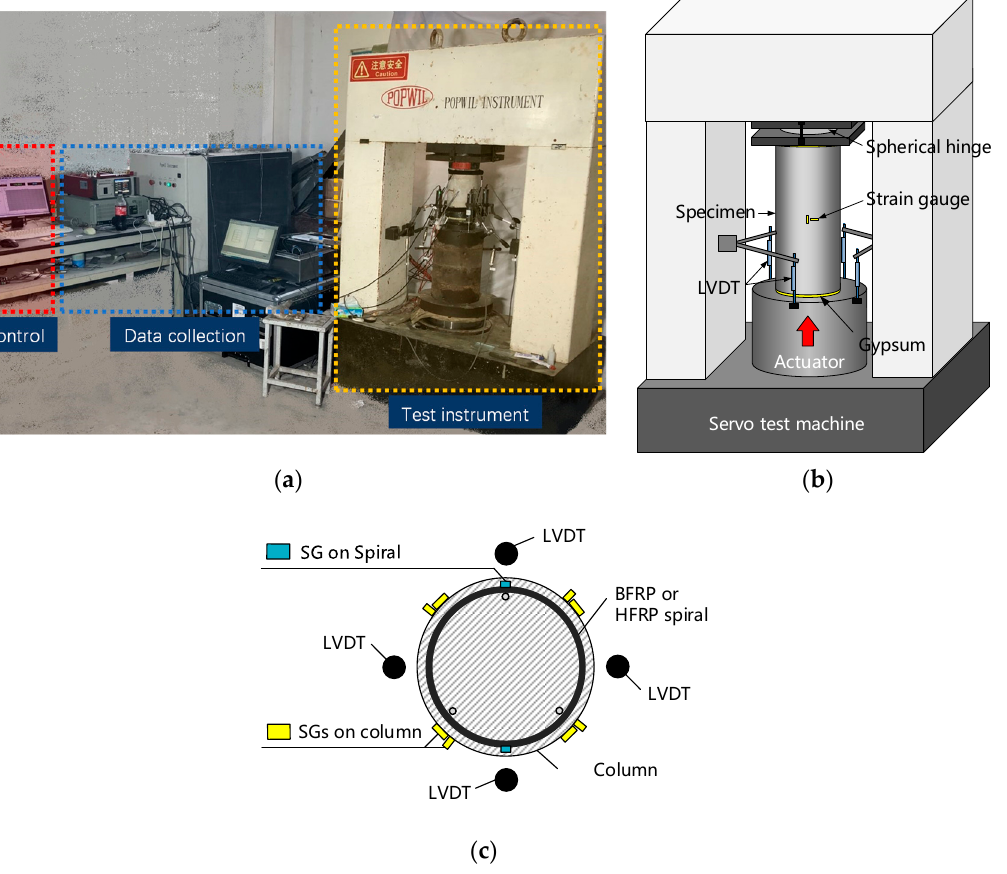
Figure 3. Test setup: ( a ) arrangement of test site; ( b ) test instrument; ( c ) sensor